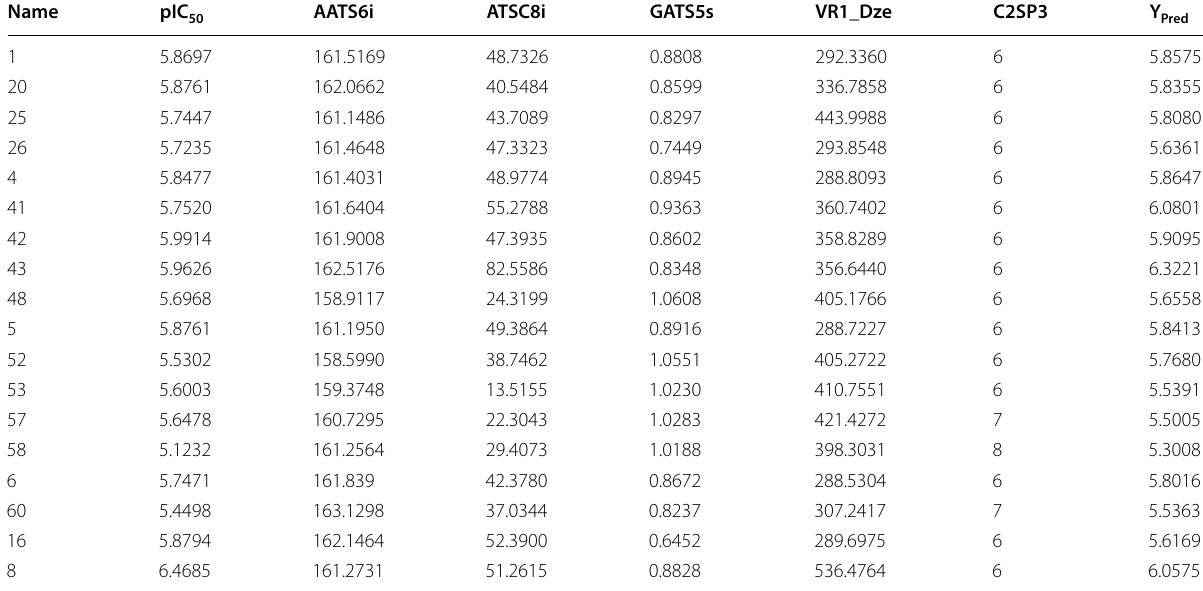
Table 7 Model parameters used in validating the model externally